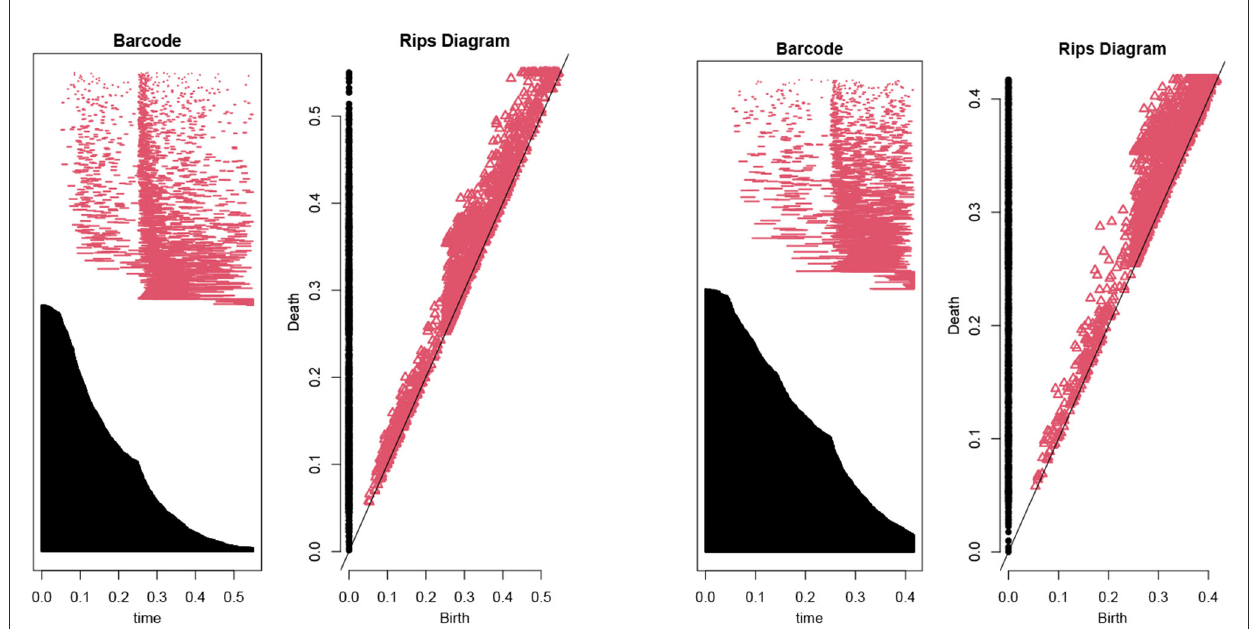
FIGURE1 The barcodes and rips diagrams both illustrate the persistent homology (Lum et al., 2013) of a given dataset. The two pictures compare the persistent homology in the case of seven features with the case of eight features. Observe that the right hand side has considerably more persistence (in both black and red markings) compared with the left hand side.